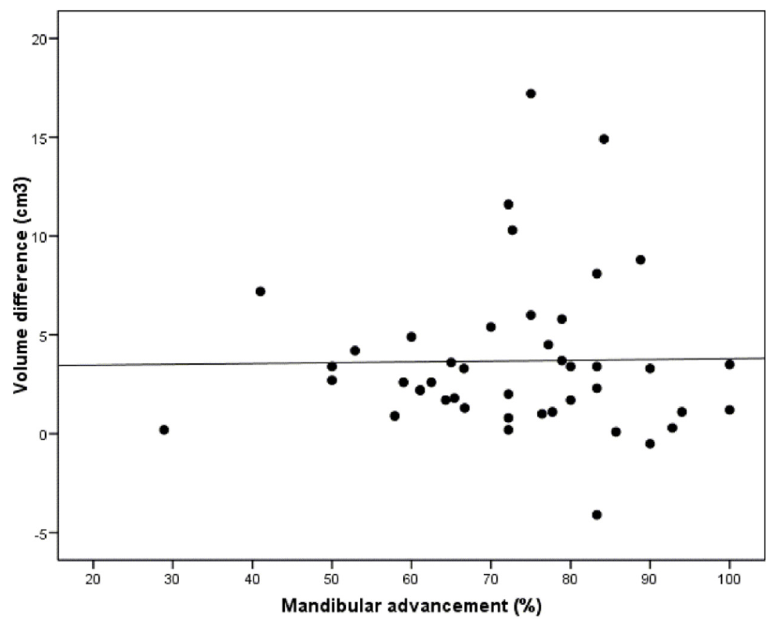
Figure 6. Correlation between the degree of mandibular advancement and the volumetric changes of the upper airway ( p = 0.922).